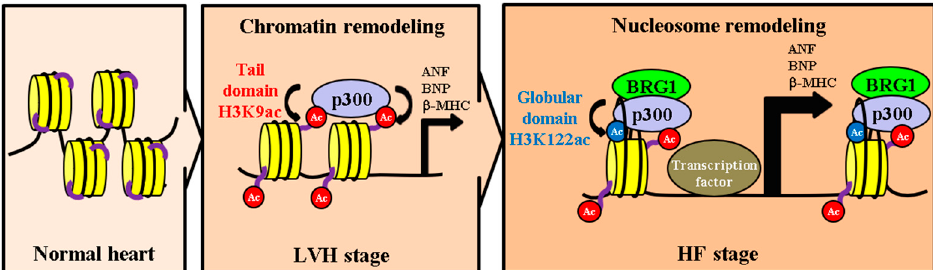
Figure 6. Model of histone acetylation during the transition from LVH to HF. LVH: left ventricular hypertrophy. HF: heart failure. Red Ac: H3K9 acetylation. Blue Ac: H3K122 acetylation. Purple lines: histone tail domains. Black lines: DNA.